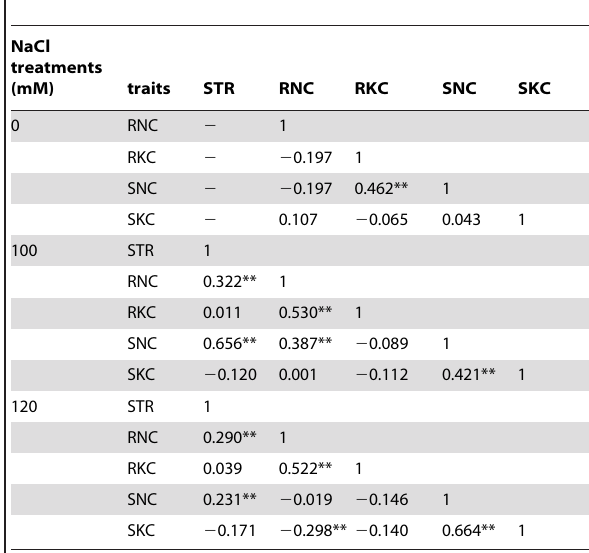
Table 2. Correlation coefficients between different traits under different NaCl conditions.